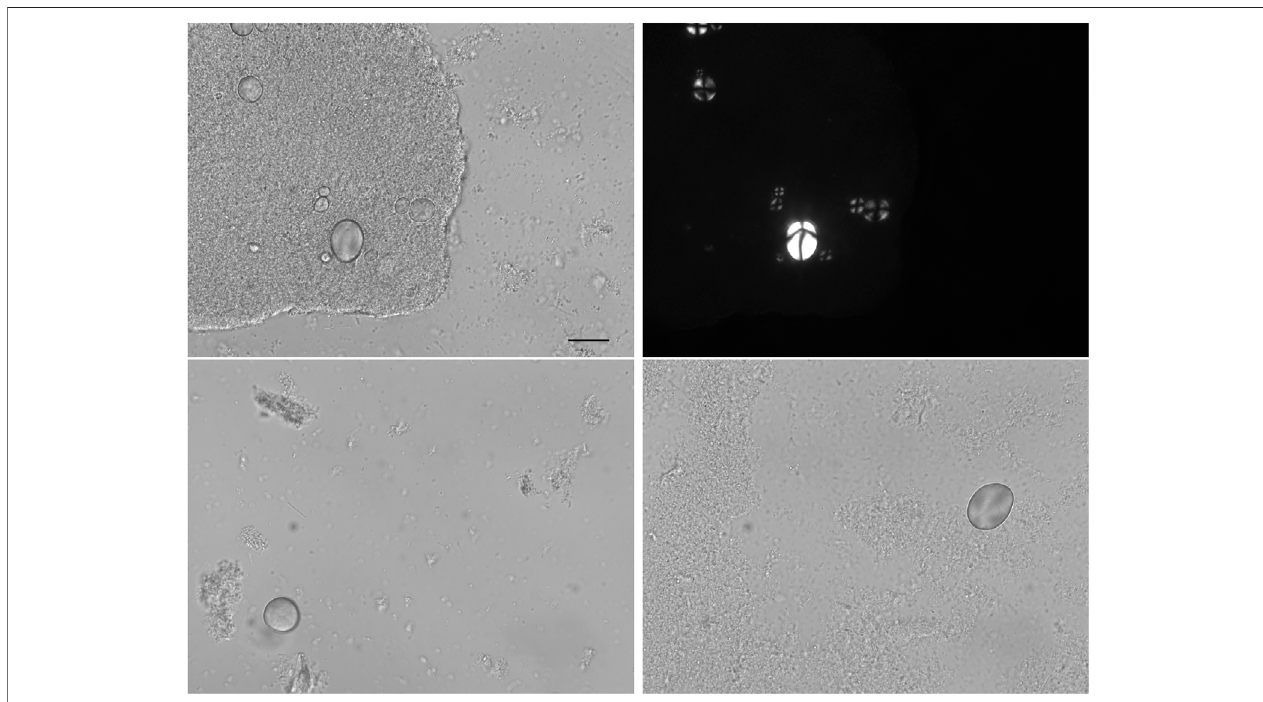
FIGURE 2 | Microscope images of bio fi lm samples that were exposed to the starch solutions. Starch granules can be seen within bacterial communities and isolated. Scale bar = 20 μ m.